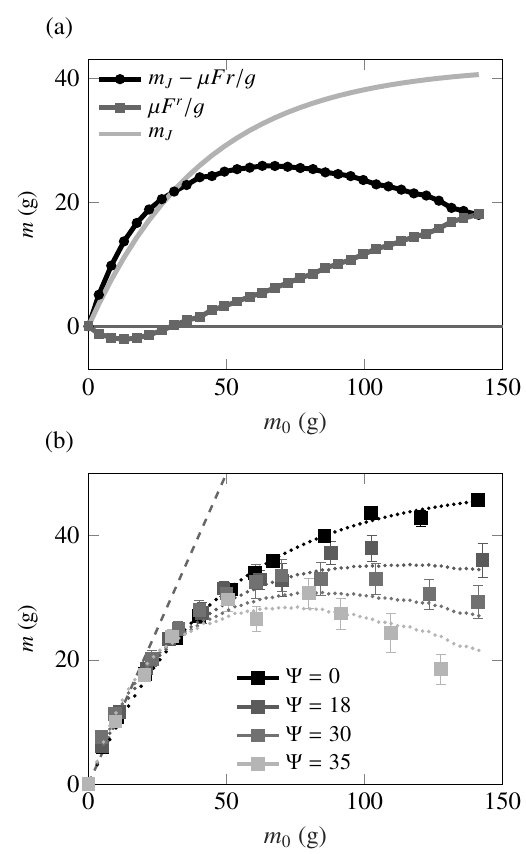
Figure 4. (a) Model curves for a vertical magnetic field. The light grey line shows the classical Janssen prediction; the grey squares line is the result of the computed magnetic mass loss µ F r /g ; the black circles line (di ff erence of both curves) gives the predicted apparent mass of the column. (b) Comparison of the model to the experimental data